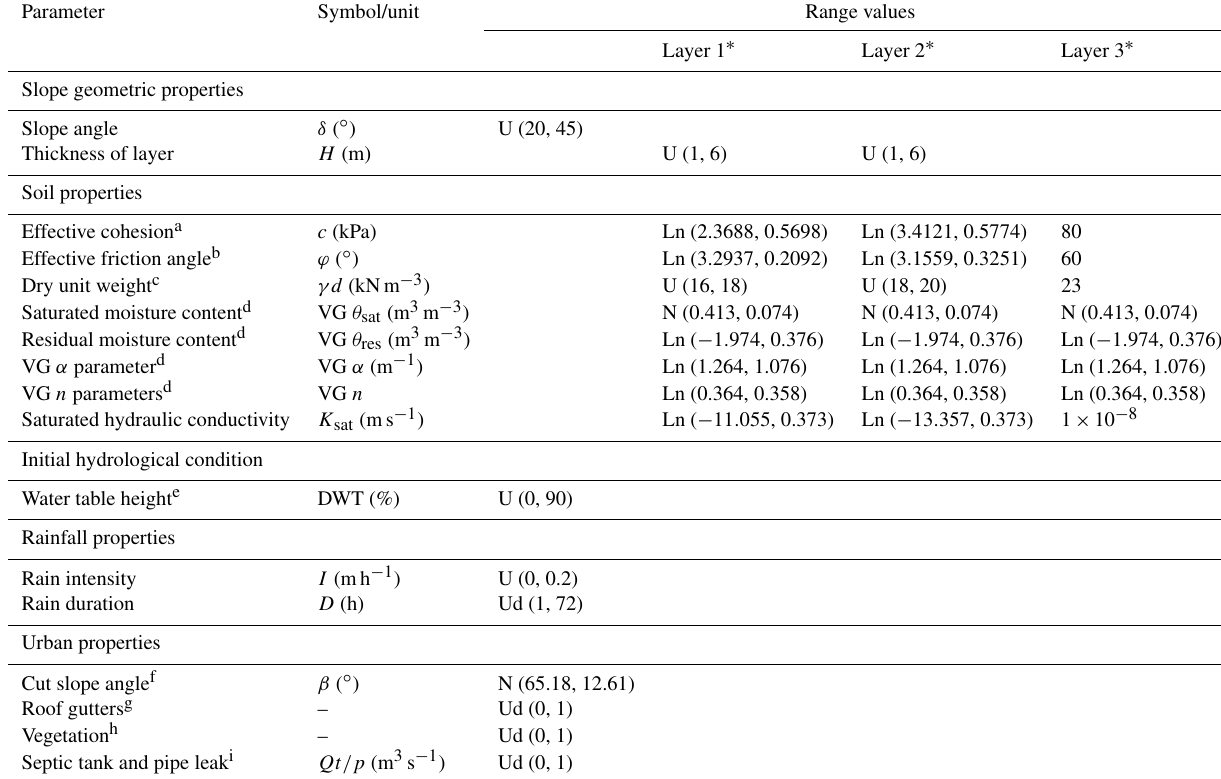
Table 1. Input factors of CHASM + and their probability distributions.